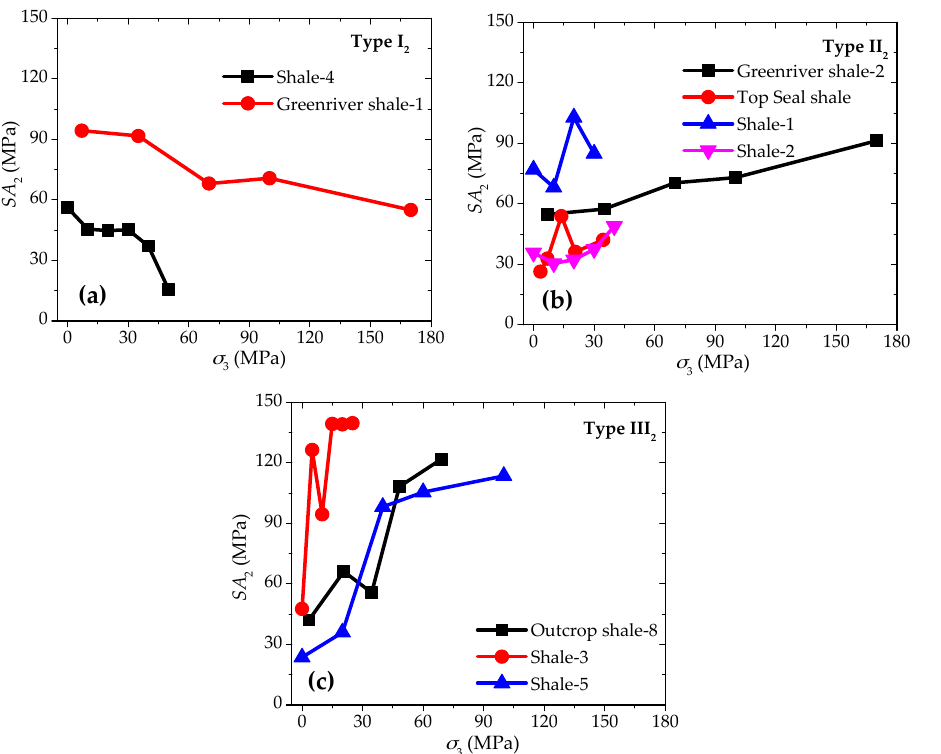
Figure 4. Three types of strength anisotropic behaviors based on SA 2 with increasing confinement. ( a ) Type I 2 ; ( b ) Type II 2 ; and ( c ) Type III 2 .